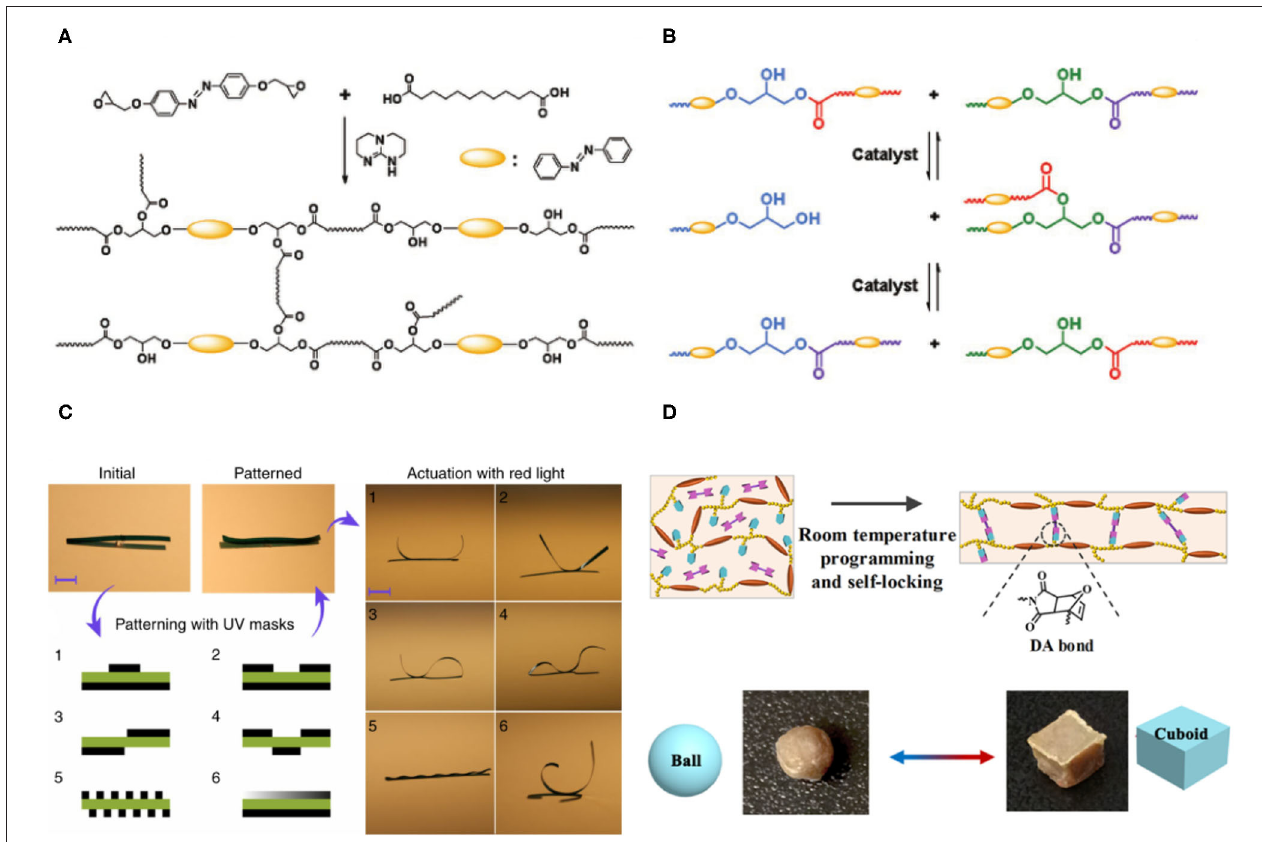
FIGURE 1 | (A) Synthesis route of the azobenzene liquid crystalline elastomers. (B) Schematic illustration of the reversible transesterification reaction. (A,B) Reprinted with permission from Lu et al. (2017) Copyright Wiley-VCH. (C) Reconfigurable shape morphing of a single actuator through synergistic use of photochemical and photothermal effects. Reprinted with permission from Lahikainen et al. (2018) Copyright Springer Nature. (D) Schematic showing the “self-lockable” liquid crystalline Diels-Alder dynamic network (LCDAN) actuators that can be (re) shaped into 3D objects at room temperature. Reprinted with permission from Jiang et al. (2020) Copyright